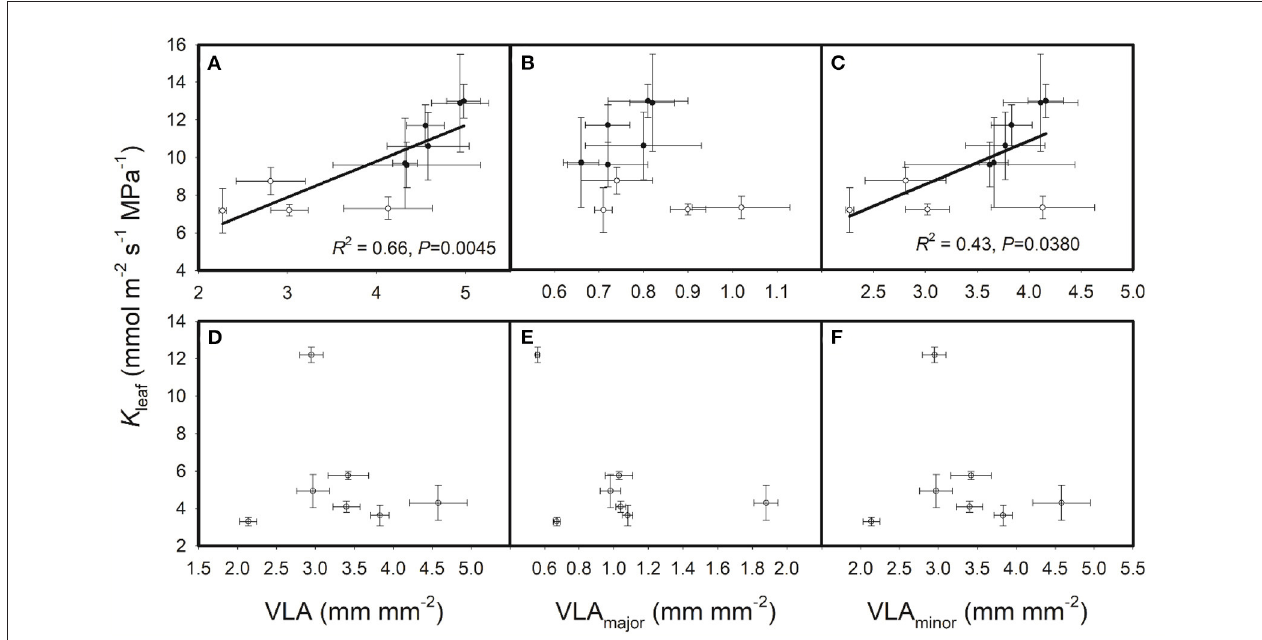
FIGURE 4 | Relationships of leaf hydraulic conductance (K leaf ) with leaf vein densities across (A–C) cultivated rice genotypes and (D–F) wild rice genotypes. The solid circles are data for the six cultivated rice genotypes in the present study, and the empty circles are data from Xiong et al. (2015, 2017)